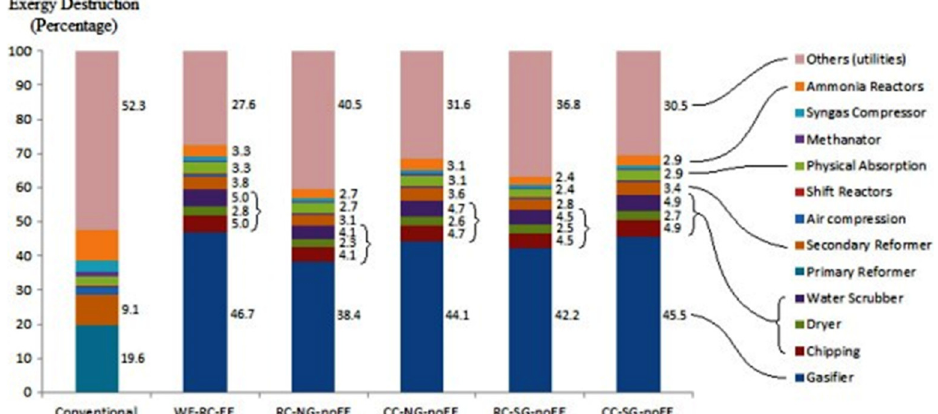
Figure 17. Exergy loss for the important components of ammonia production systems, such as reactor, compressor, and reformer for conventional, conventional, WF-RC-EE, NG-RC-no EE, NG-CC-no EE, SG-RC-no EE, SG-CC-no EE. Reprinted with permission [69].